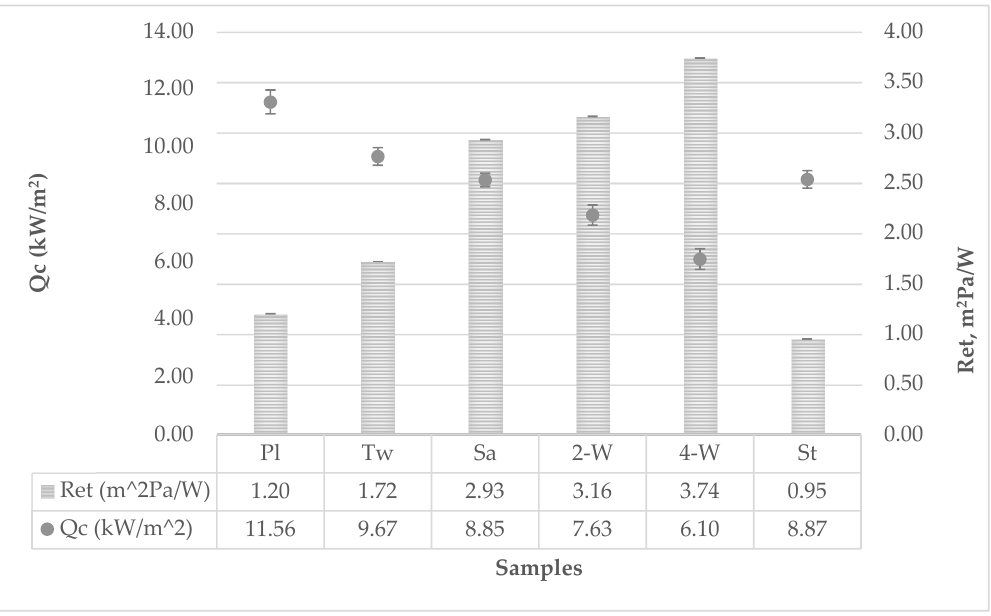
Figure 4. Vapor resistance–Leaked heat flux density through the sample to the calorimeter diagram.